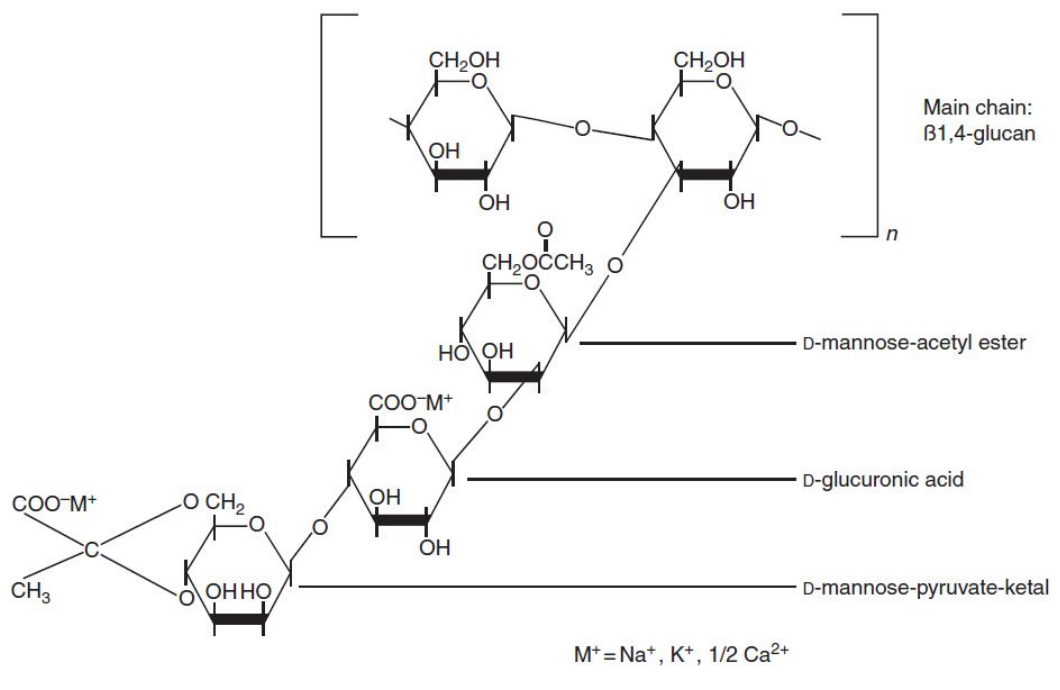
Figure 2. Chemical structure of xanthan gum [51].